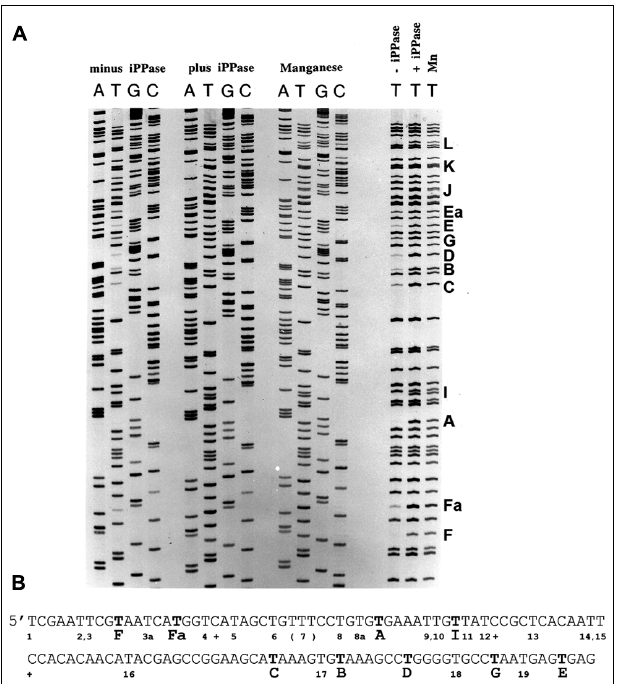
FIGURE 3 | Pyrophosphorolysis detected in DNA sequencing reactions with FIDELITY TM . (A) Three sets of DNA sequencing reactions were performed (see Materials and Methods): without a pyrophosphorolysis inhibitor (minus iPPase), with added yeast inorganic pyrophosphatase (plus iPPase), and with manganese. Results similar to the manganese supplemented reactions were detected with calcium. No or faint bands were detected for several products terminating inT in the minus iPPase reactions. Reactions terminating inT for all sets of reactions are shown to the right; missing or faint reaction products terminating inT are indicated by a capital letter to the right of the lanes. (B) The DNA sequence for the reactions shown in panel A. BoldTs indicate missing or faint terminatingTs; the letter code identifies pyrophosphorolysis sensitive sites.The sequences are analyzed in Table 3 . Pyrophosphorolysis-resistantTs are indicated by a number below the